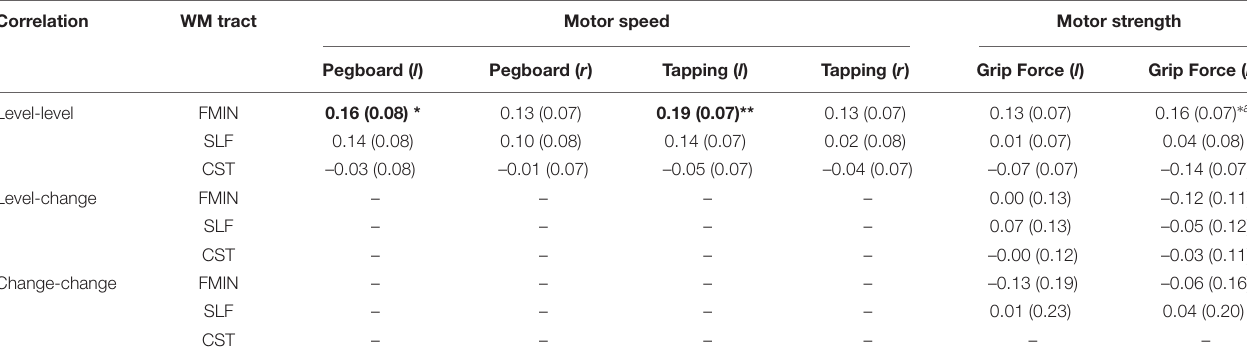
TABLE 9 | Results of bivariate LGC models (level-level, level-change, change-change). Correlation WM